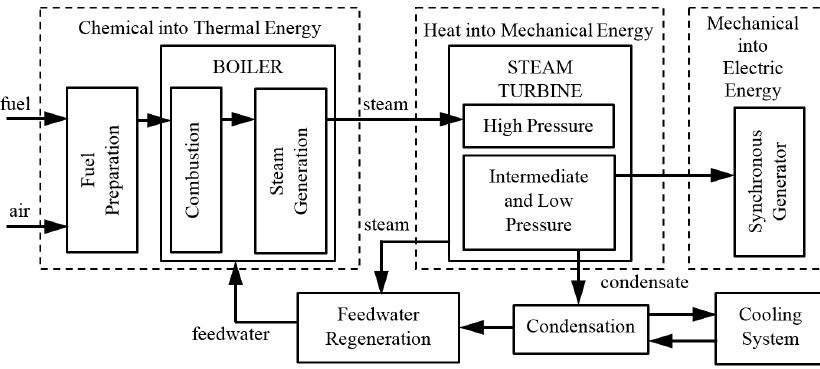
Figure 1. Power plant process flowchart.